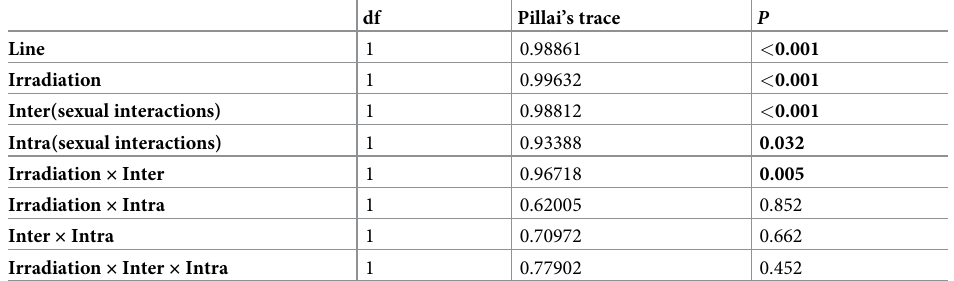
Table 2. Test statistics of a multivariate analysis of variance with all 18 irradiation response genes as dependent